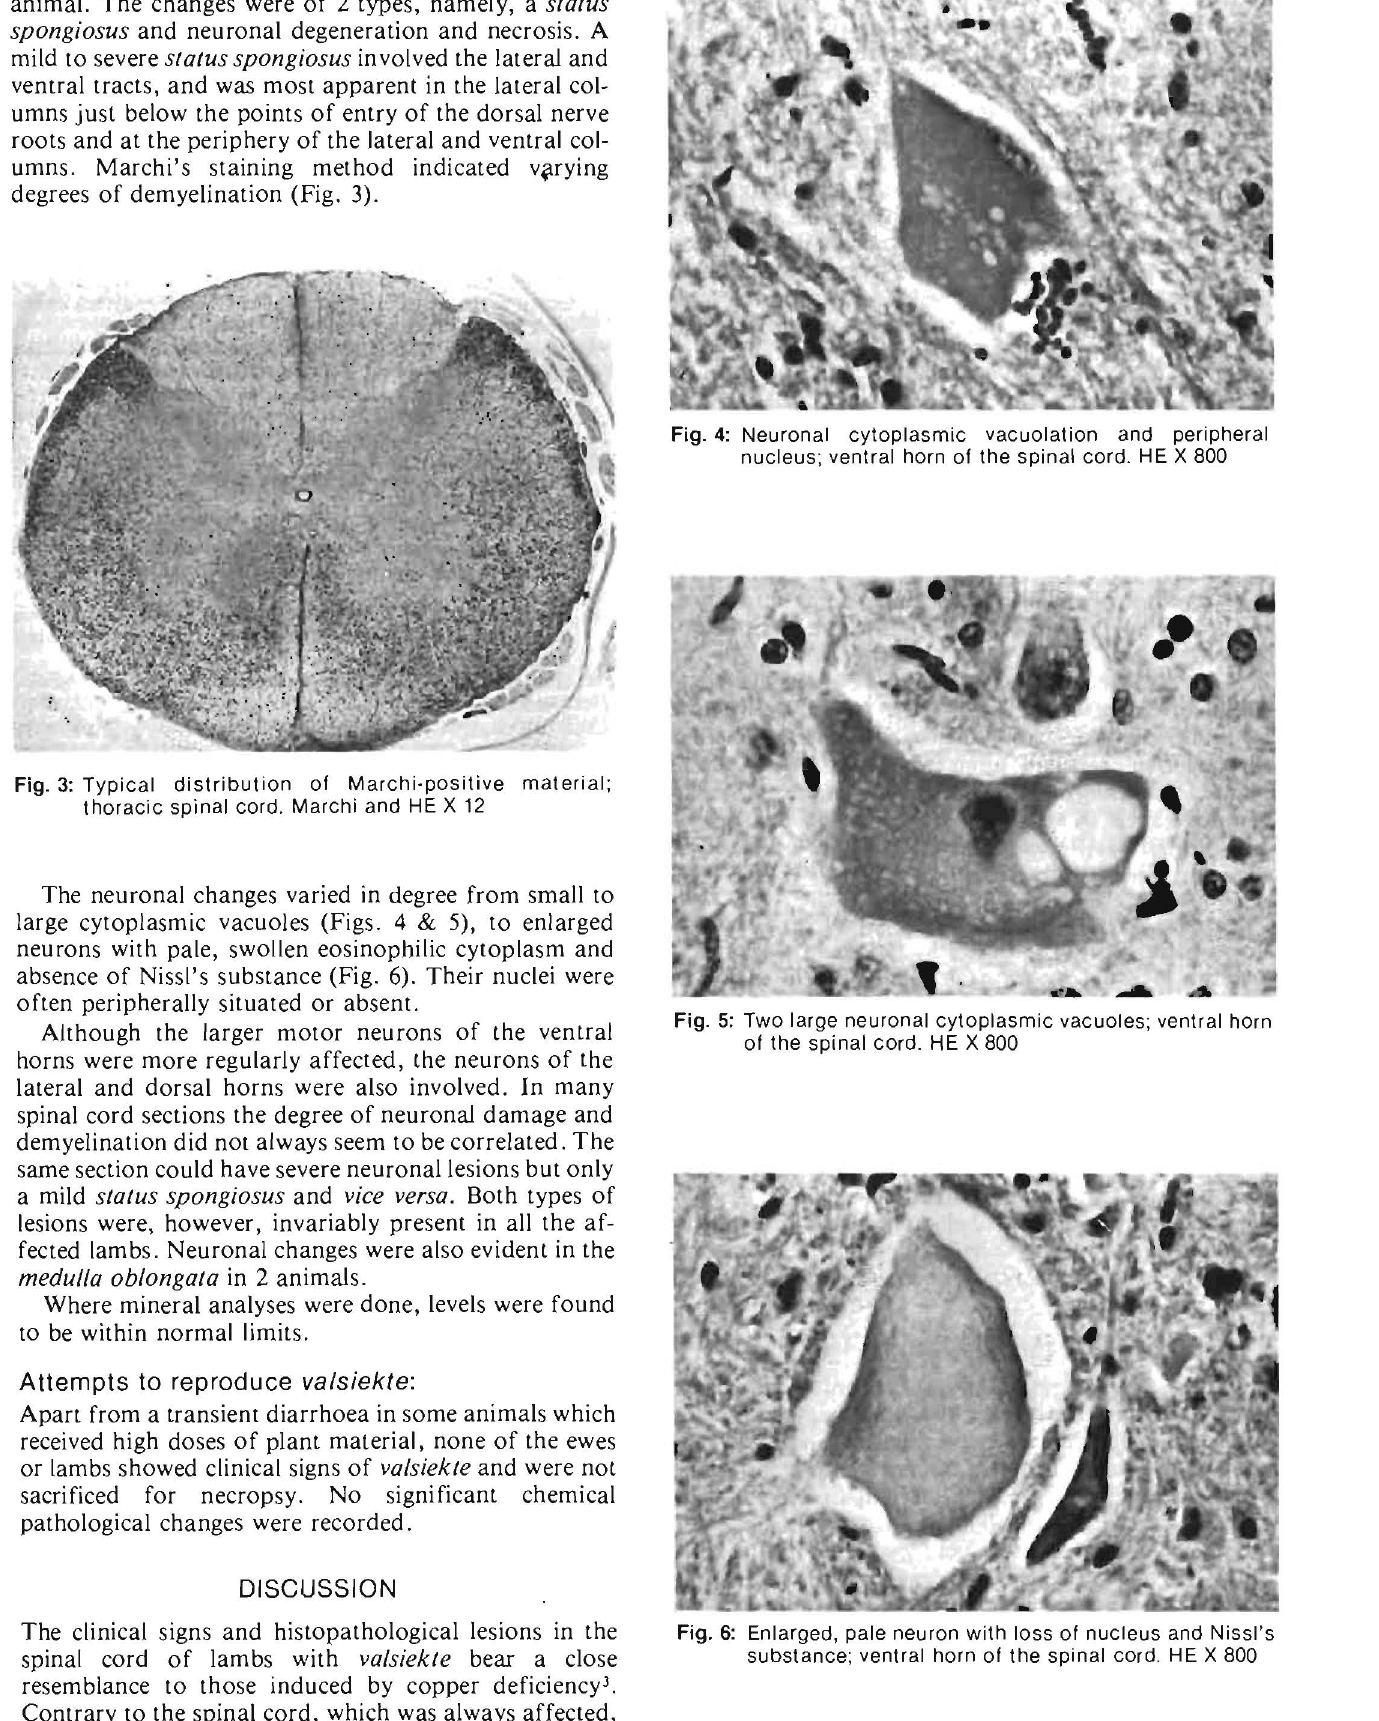
Fig. 6: Enlarged, pale neuron with loss of nucleus and Nissl's substance; ventral horn of the spinal cord. HE X 800